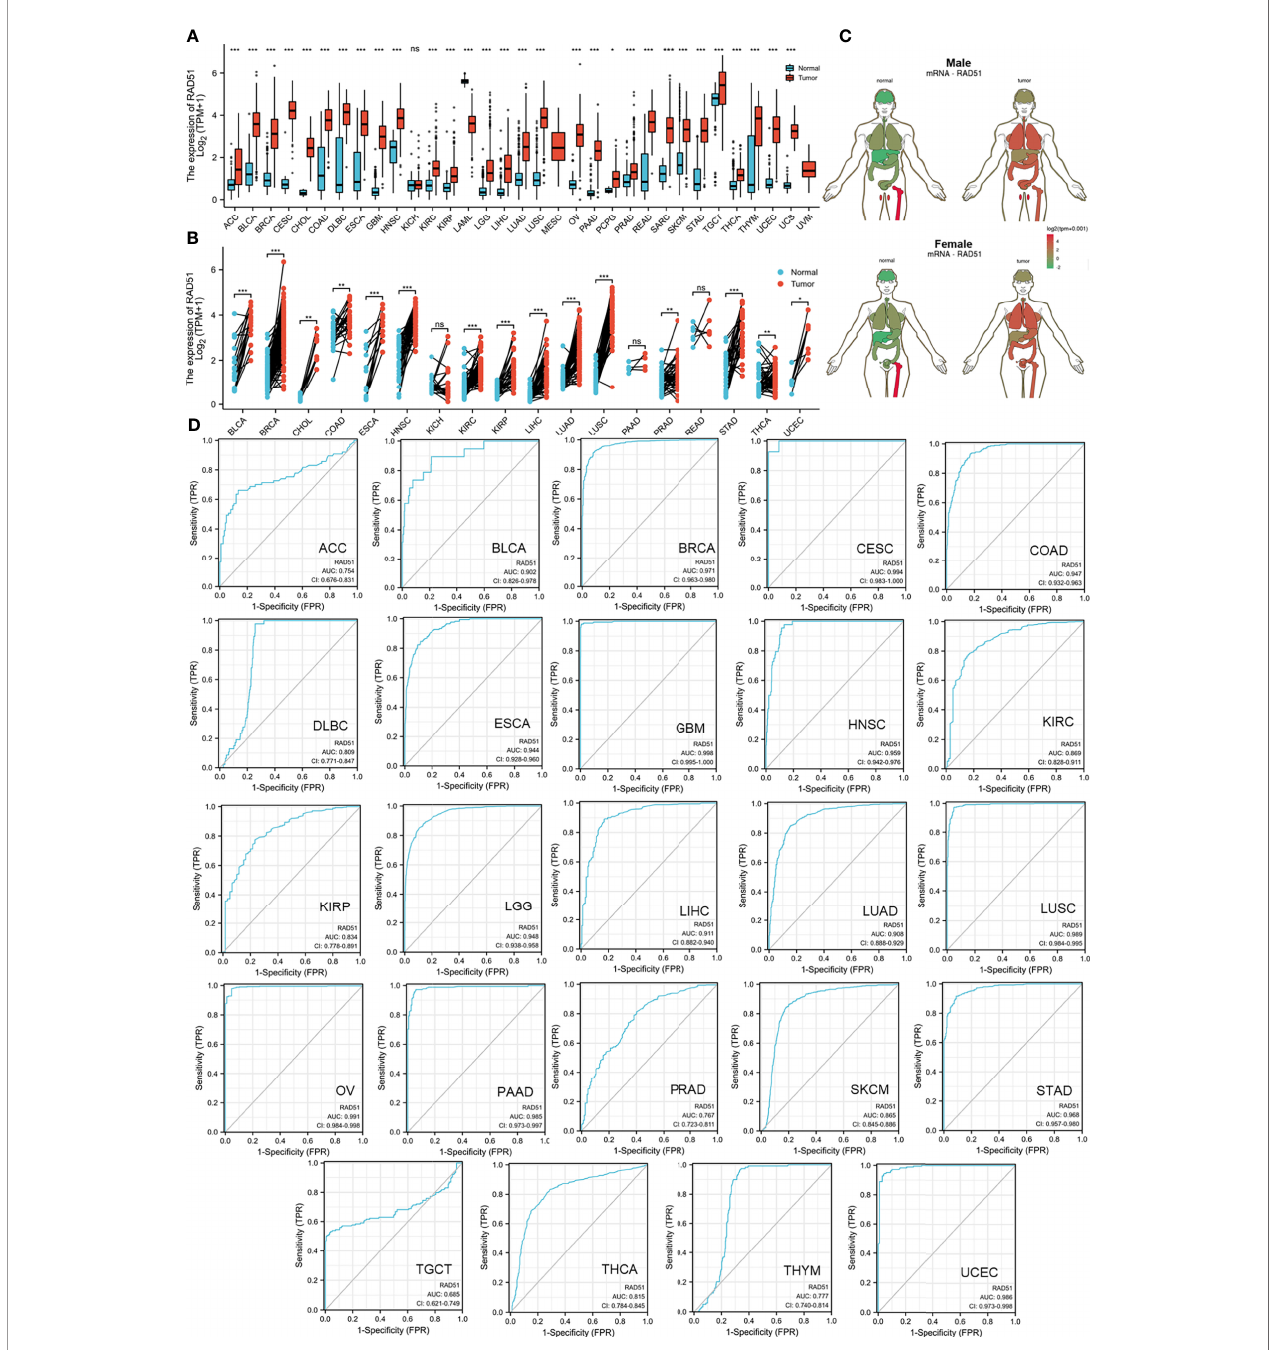
FIGURE 2 | The diagnostic value of RAD51 in cancers. (A) The gene expression pro fi le of RAD51 across all tumor samples and normal tissues. TCGA and GETx data were plotted. (B) Paired sample expression pro fi le of RAD51 across all tumor samples and normal tissues. TCGA data were plotted. The full names of the cancer type abbreviations can be found in S-Table 1 . (C) Anatomy plot of the gene expression pro fi le of RAD51 across all tumor samples and paired normal tissues in females and males. (D) Diagnostic ROC of RAD51 in different cancer types. TCGA and GETx data were plotted. (ns, not signi fi cant; *P<0.05; **P<0.01;